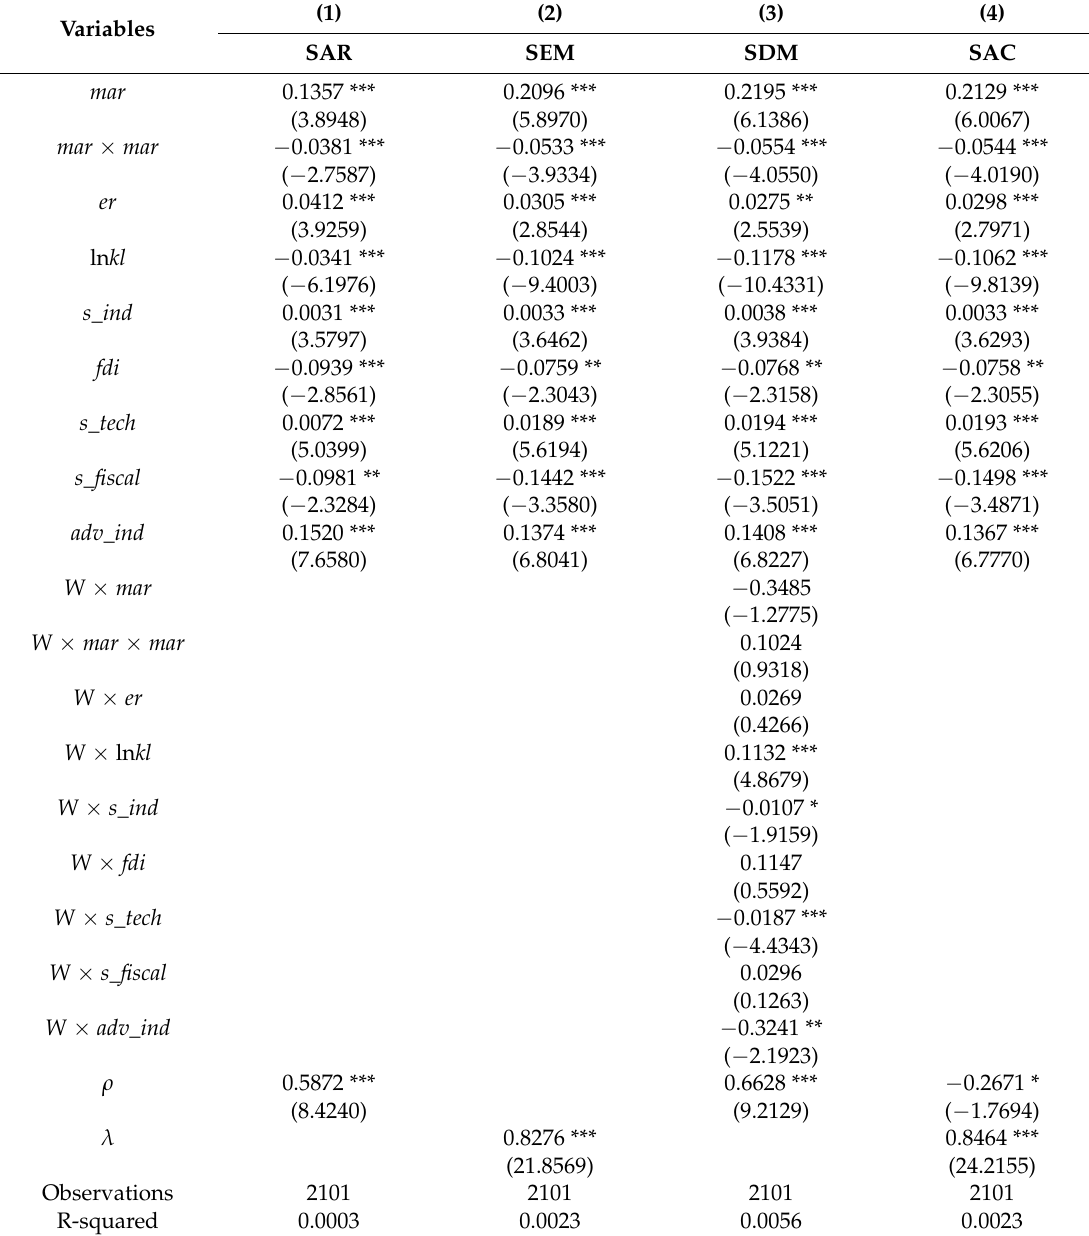
Table 3. Spatial effects of MAR externality on